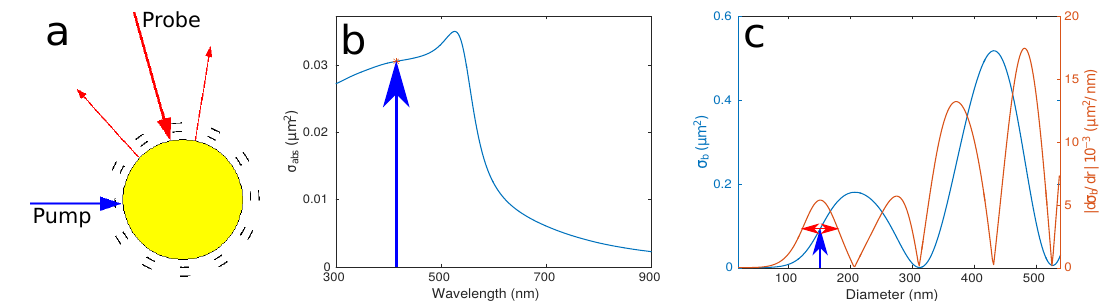
Figure 1. ( a ) schematic representation of the experiment, showing the spherical nanoparticle, the pump and probe laser beams and the vibrations; ( b ) the absorption cross-section for a 150 nm gold nanoparticle computed [3] with the fixed pump wavelength ( λ pump = 415 nm) marked; ( c ) backscattering cross-section (blue) and the optical sensitivity (orange) of a variable sized gold nanoparticle (0–550 nm) illuminated with a fixed probe laser wavelength ( λ probe = 780 nm) in water. The first optimal size for acting as a detector is shown ( ∼ 160 nm); here, the backscattering cross-section is very sensitive to the size and, as the particle vibrates, the backscatter is modulated, additional maxima in the sensitivity are shown, but these are for increasingly large